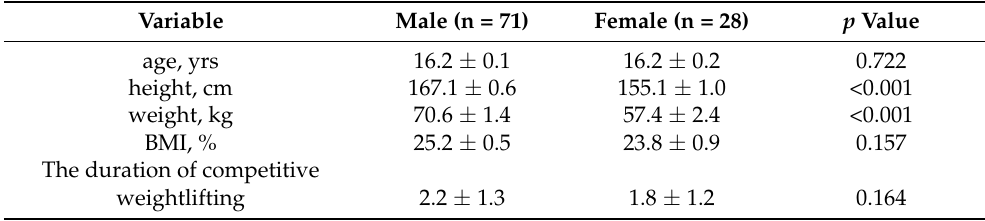
Table 1. Characteristics of adolescent